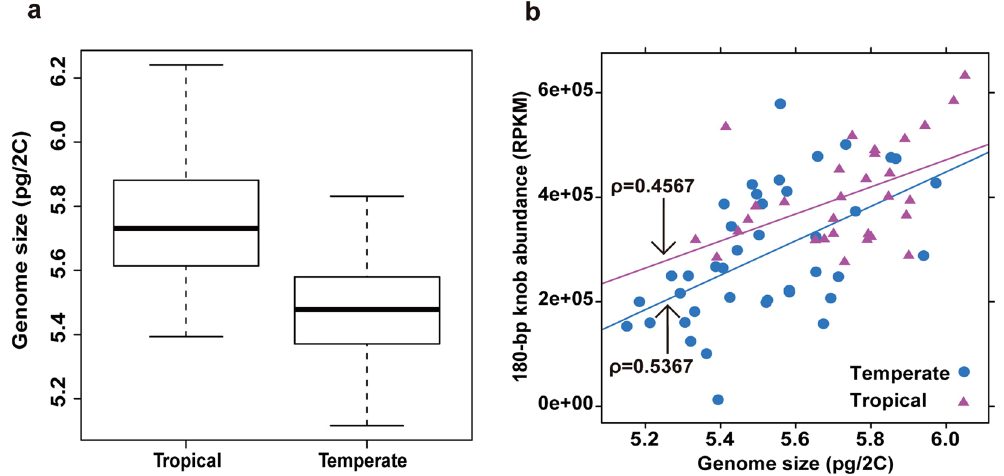
Figure 1. ( a ) Significant difference in genome size (pg) between tropical (n = 74) and temperate (n = 74) inbred lines ( P = 2e-16 based on one-way ANOVA). The boxes indicate the first quartile (bottom line), the median (central line) and the third quantile (top line). The whiskers represent the standard deviation. ( b ) Correlation between genome size and RPKM of 180-bp knob based on genome size data from 70 genomes. The x-axis is absolute nuclear DNA content, and the y-axis is RPKM, which is a measure of 180-bp knob abundance. Blue circles and purple triangles indicate temperate and tropical maize lines, respectively. Regression lines are shown for both the temperate (blue circle) and tropical (purple triangle) lines. Correlation values are ρ = 0.5367 for temperate inbreds and ρ = 0.4567 for tropical